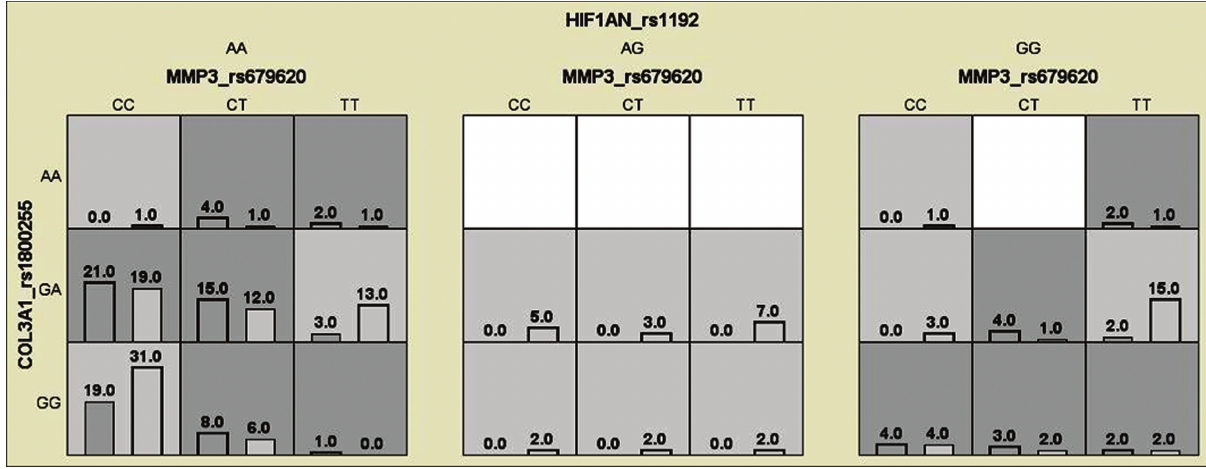
Figure 2 - Distribution of high-risk and low-risk genotypes in the best three-locus model. The distribution shows high-risk (dark shading) and low-risk (lightshading)genotypesassociatedwithkneeOAinthethree-locusinteractiondetectedbyMDRanalysis.Thepercentageofosteoarthriticsubjects(left black bar in boxes) and control subjects (right hatched bar in boxes) is shown for each three-locus genotype combination. Boxes were labeled as high-risk if the ratio of the percentage of cases to controls met or exceeded the threshold of 1.0. Boxes were labeled as low-risk if the threshold was not exceeded. Based on the pattern of high-risk and low-risk genotypes, this three-locus model is evidence of gene to gene